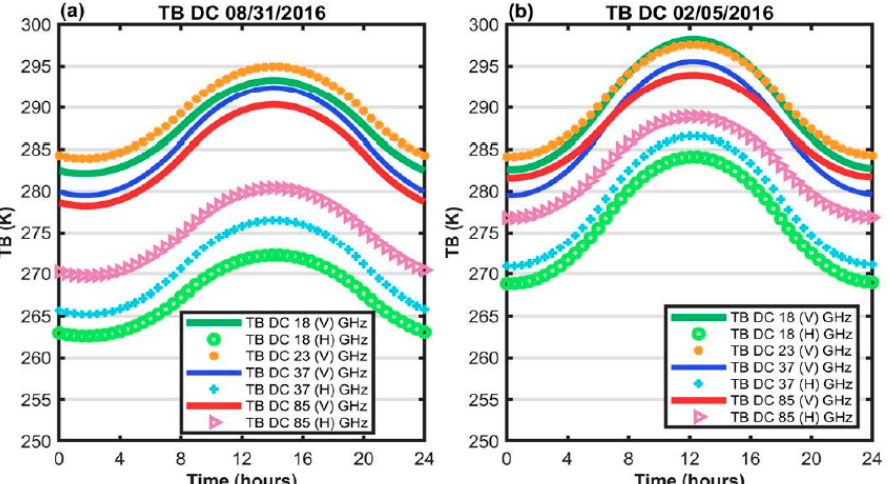
Figure 7. Comparison of constructed TB diurnal cycle for different PMW channels in two contrasting seasons at ( a ) 45.9 ◦ N and 103 ◦ W with boreal and xeromorphic shrubland land cover for 31 August 2016; and ( b ) 3.6 ◦ N and 142.7 ◦ W with wooded and non-wooded grassland land cover for 5 February 2016. Time in each subplot is in local hours.